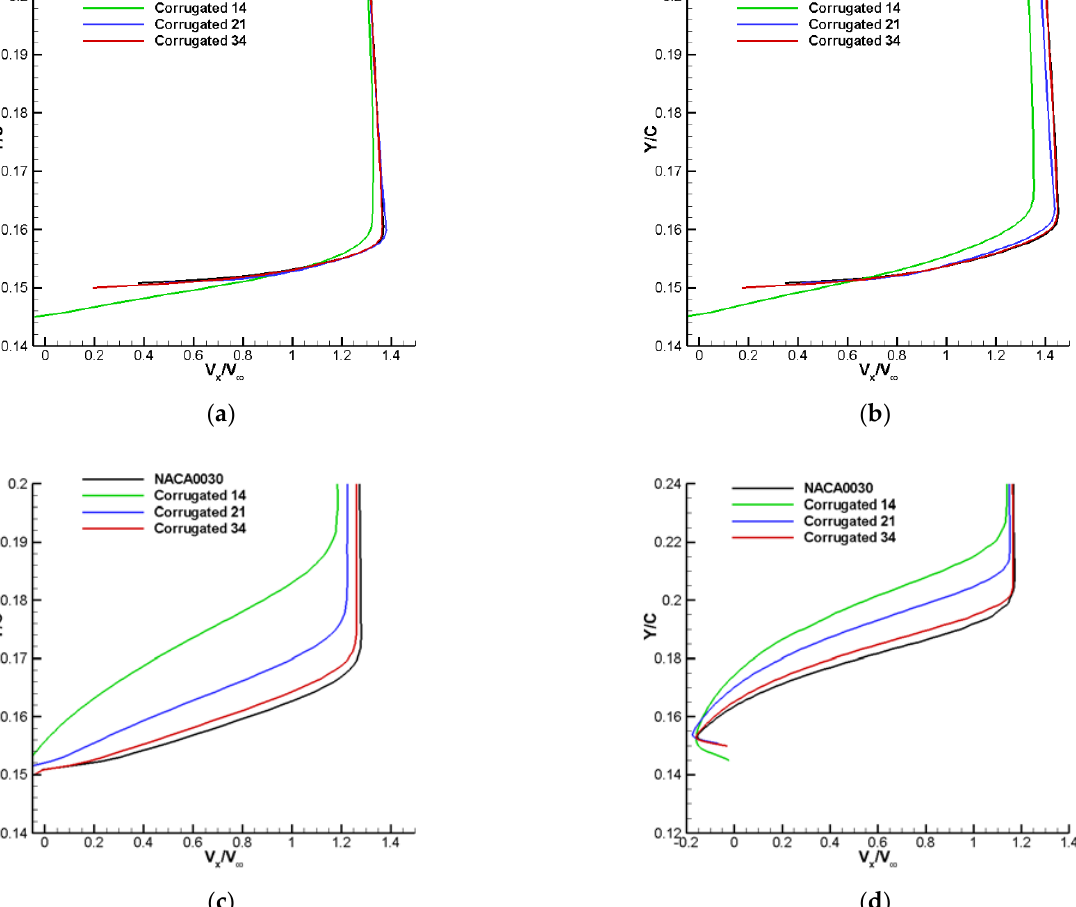
Figure 6. Time − averaged stream − wise velocity profile at the upper surface with x/c = 30% Figure 6. Time-averaged stream-wise velocity profile at the upper surface with x/c = 30% chord-wise chord − wise position: ( a ) 0°, ( b ) 8°, ( c ) 16°, and ( d ) 20°. position: ( a ) 0 ◦ , ( b ) 8 ◦ , ( c ) 16 ◦ , and ( d ) 20 ◦